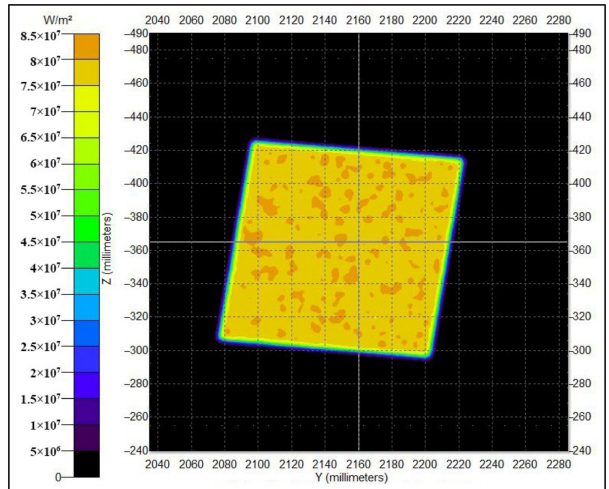
Figure 16. Illuminance map of the previous plane of the target